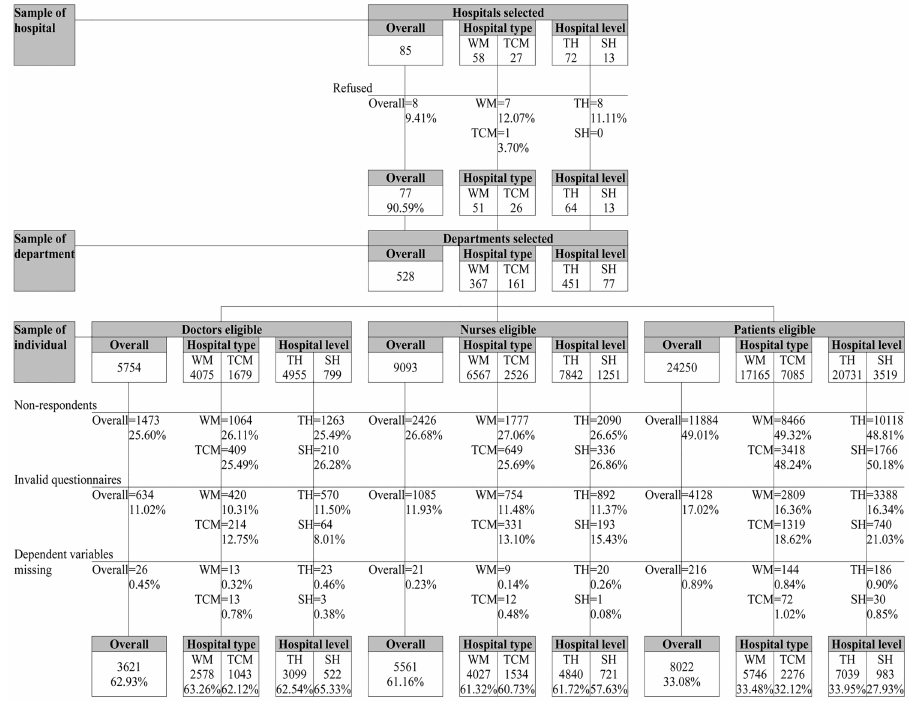
Fig 1. Flowchart for recruitment and response rates of the participants. WM, Western Medicine.TCM, Traditional ChineseMedicine.TH, Tertiary Hospital. SH, SecondaryHospital.